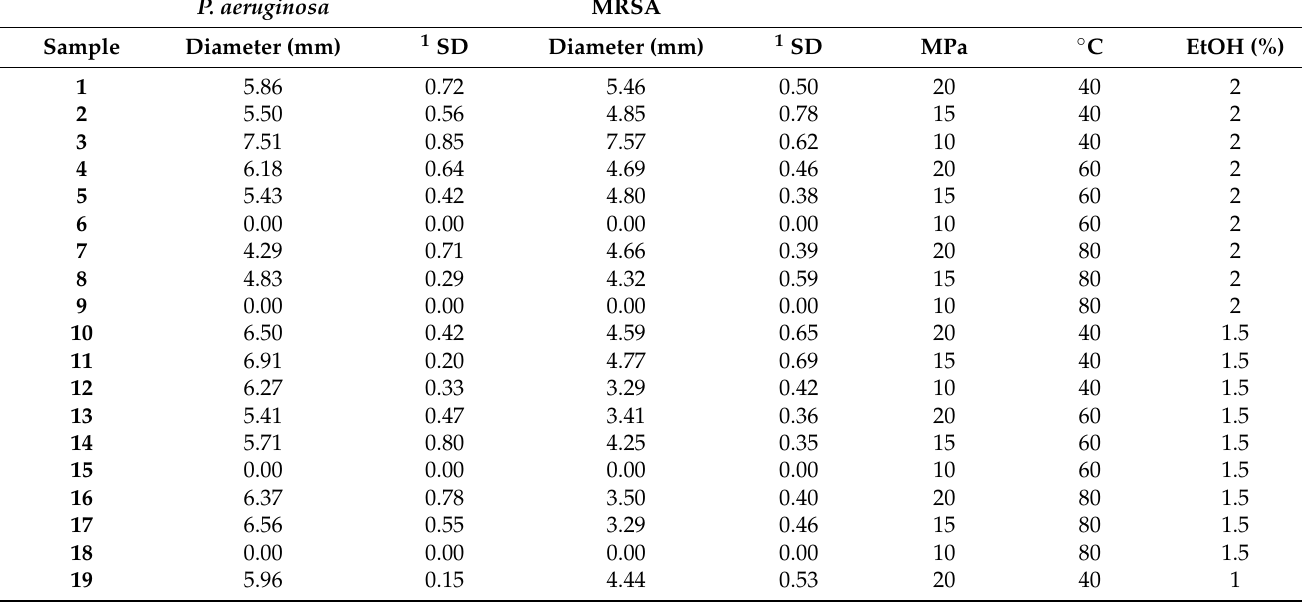
Table 1. The inhibitory zones of the clary sage SFE extracts after TLC-DB and the extraction parameters of SCF procedure. P.